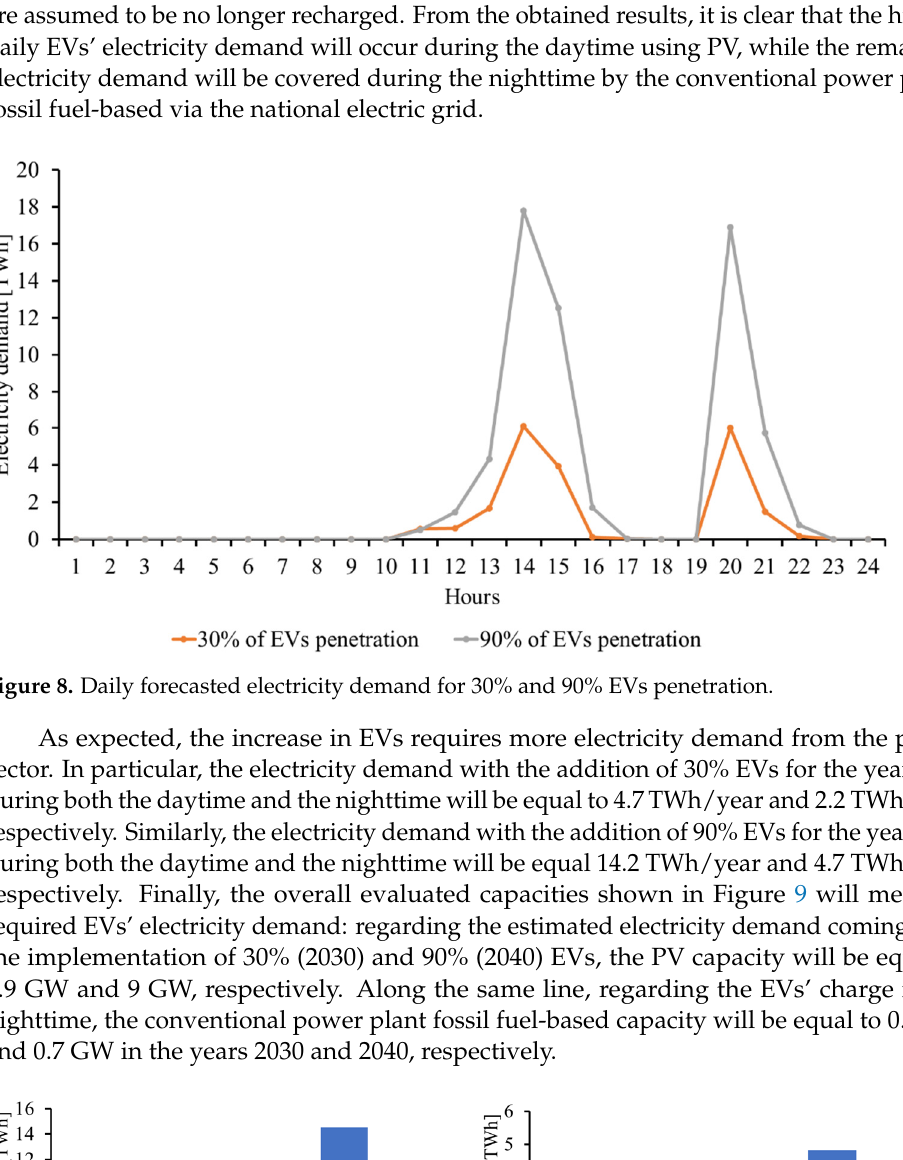
Figure 9. Yearly EVs’ electricity demand with ( a ) added PV (daytime) and ( b ) added conventional power plant (nighttime) capacities.